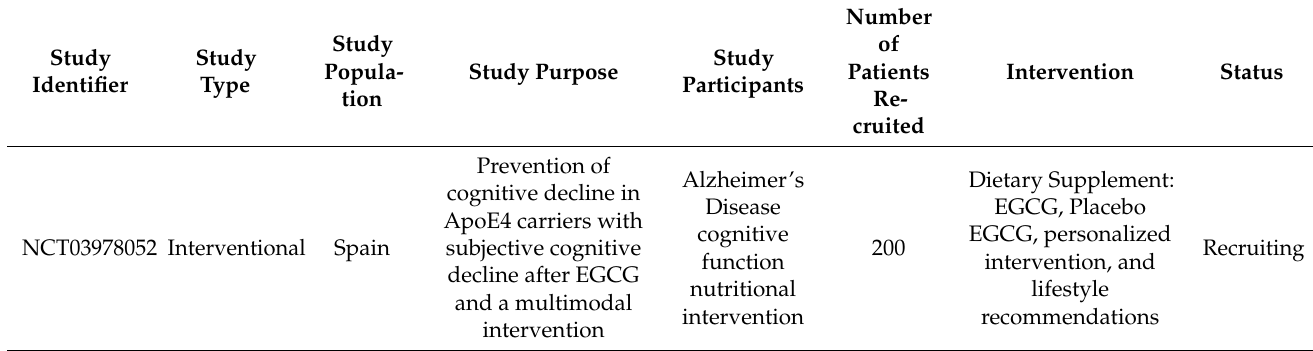
Table 2. Current clinical studies of EGCG on AD and